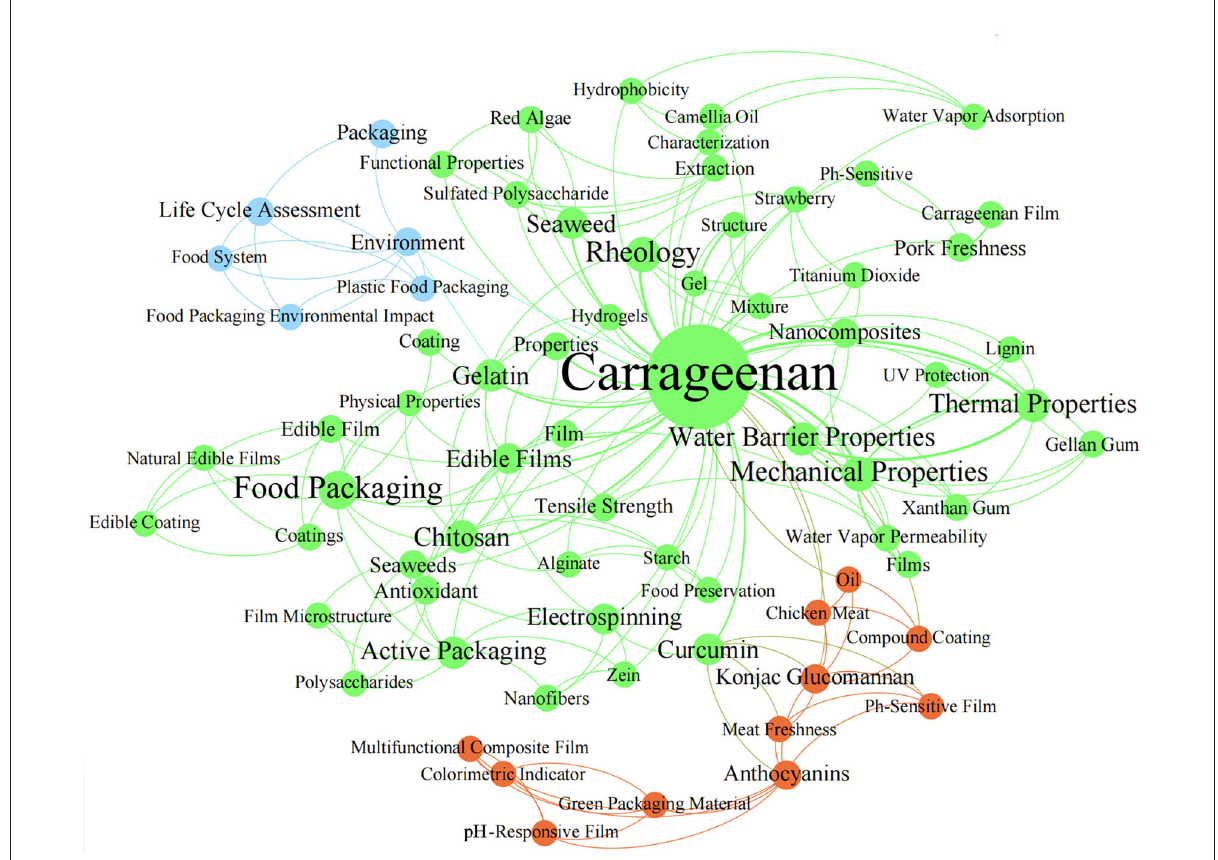
FIGURE1 The network visualization of keyword relevance in high-level